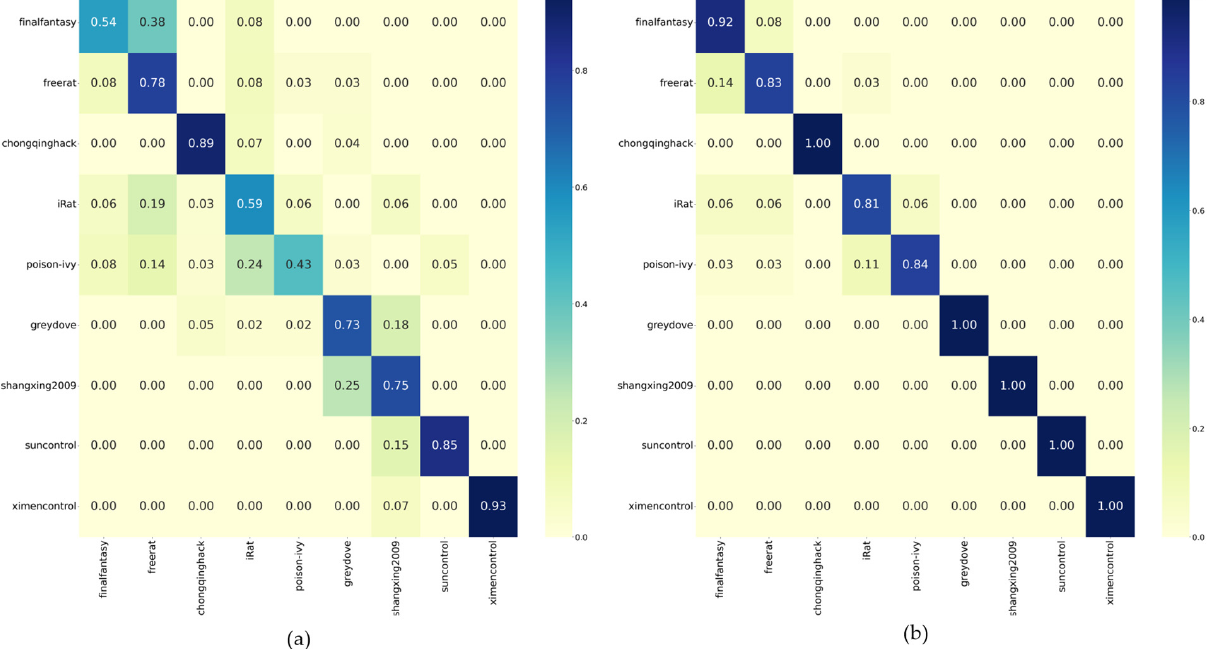
Figure 5. ( a ) The loss curve of the direct training model. ( b ) DA-Transfer model loss curve. 4.1.2. Comparison with Existing Networks We compare the performance of six classification models, which are the direct train- ing model, the DA-Transfer method training model, the classical traffic classification model by Deeppacket [16], CNN-LSTM [17], and the transfer classification models